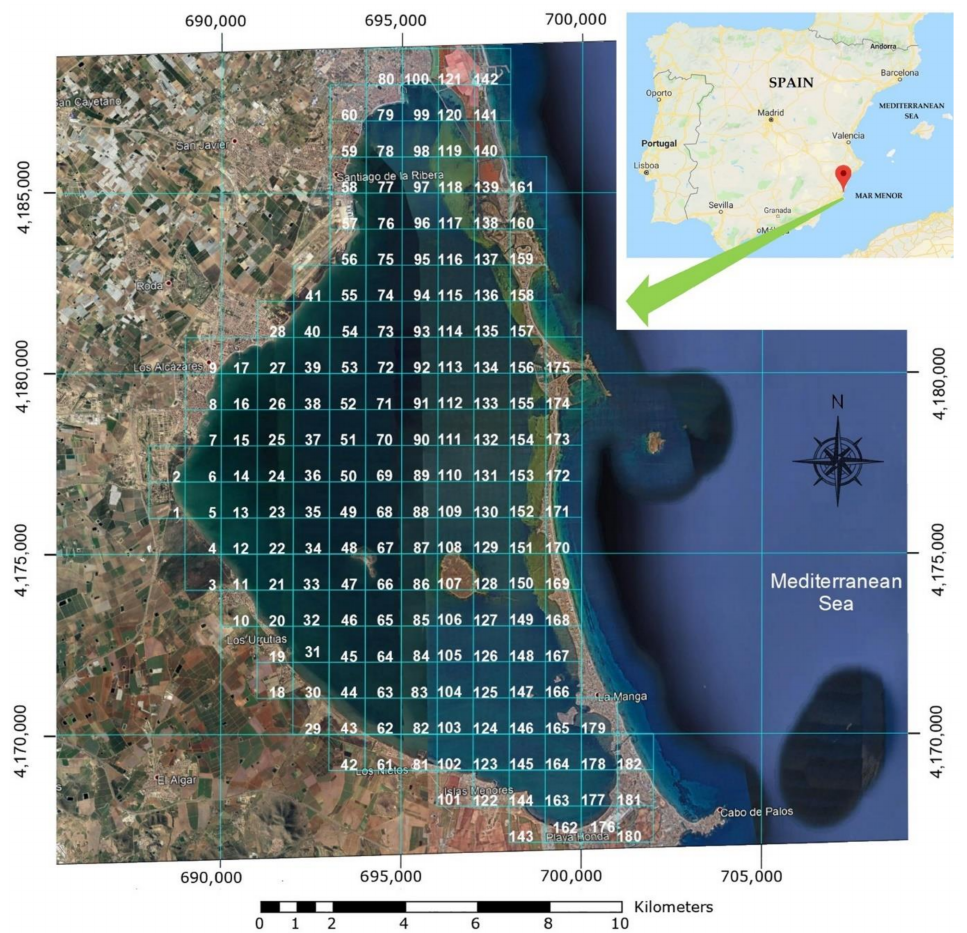
Figure 6. View of the Mar Menor divided into 182 boxes for exploration purposes and their GPS coordinates.